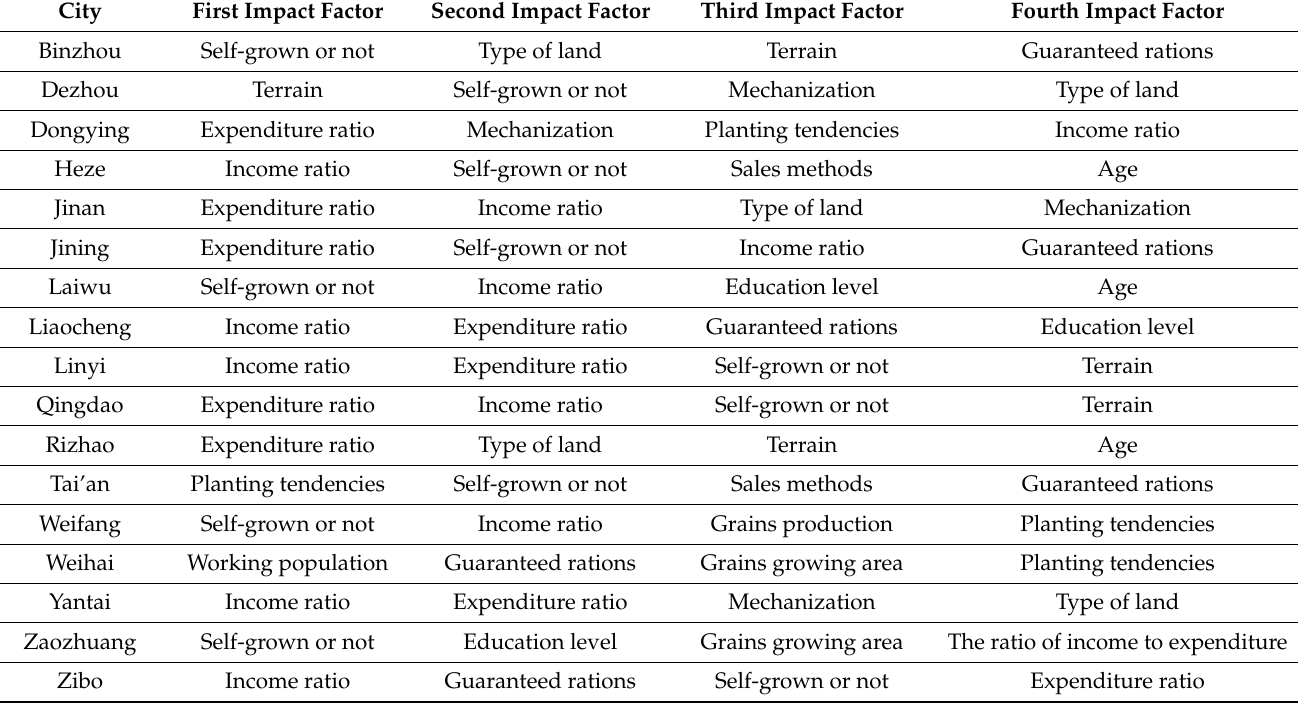
Table 3. Statistical summary of main influencing factors of farmers’ willingness to grow grains in 17 cities of Shandong